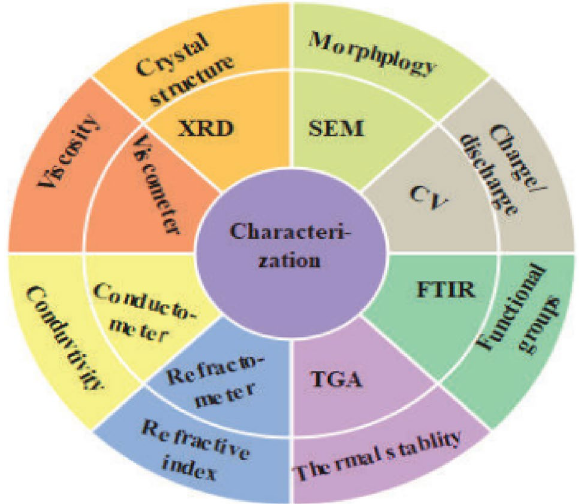
Fig. 7 The schematic view of characterization of electrolyte materi- als for ZABs modified from reference